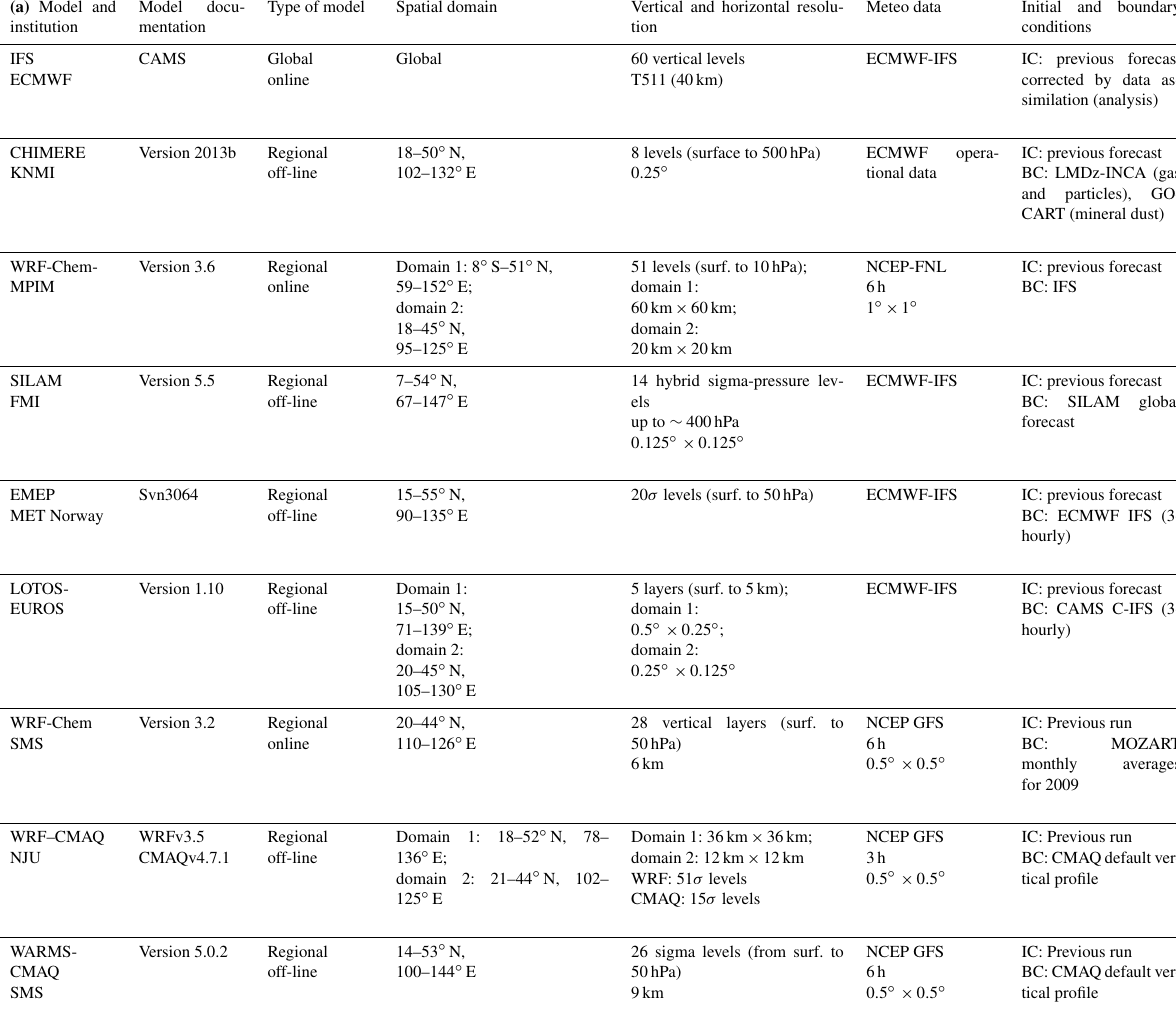
Table 2. Description of the different models. (a) Model and